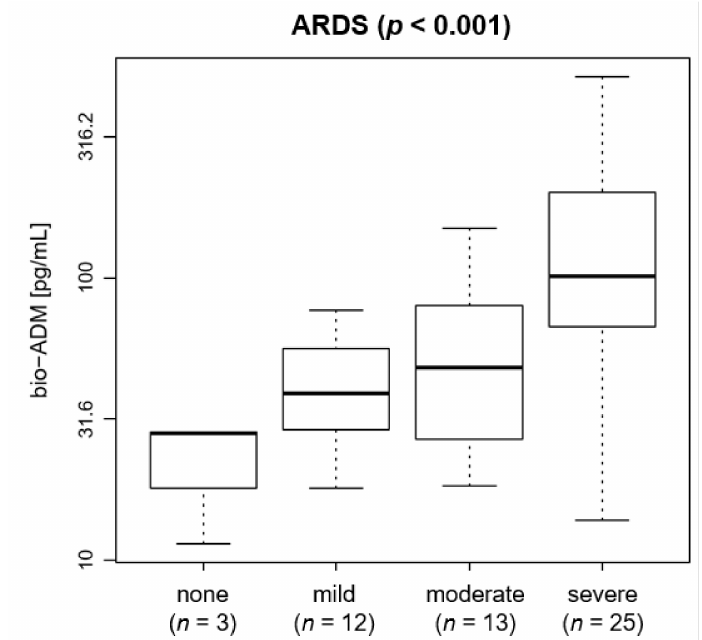
Figure 1. Boxplot of bio-ADM by ARDS in 53 COVID-19 patients at ICU admission ( p < 0.001). The distribution of bio-ADM is shown as boxes, with the lower end of the boxes representing the 25th and the upper end of the boxes representing the 75th percentile (interquartile range), the middle line representing the median, and the whiskers showing the minimal and maximal bio-ADM levels. Horizontal line at 70 pg/mL. The y axis uses a logarithmic scale. ARDS: acute respiratory distress syndrome; bio-ADM: bioactive adrenomedullin; ICU: intensive care